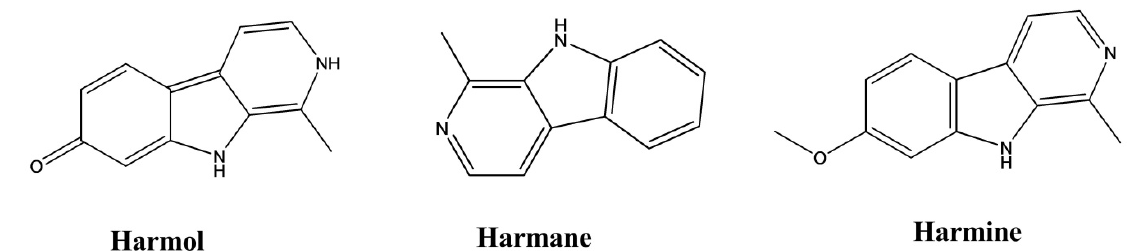
Figure 13. Antiplatelet activity of indole alkaloids.